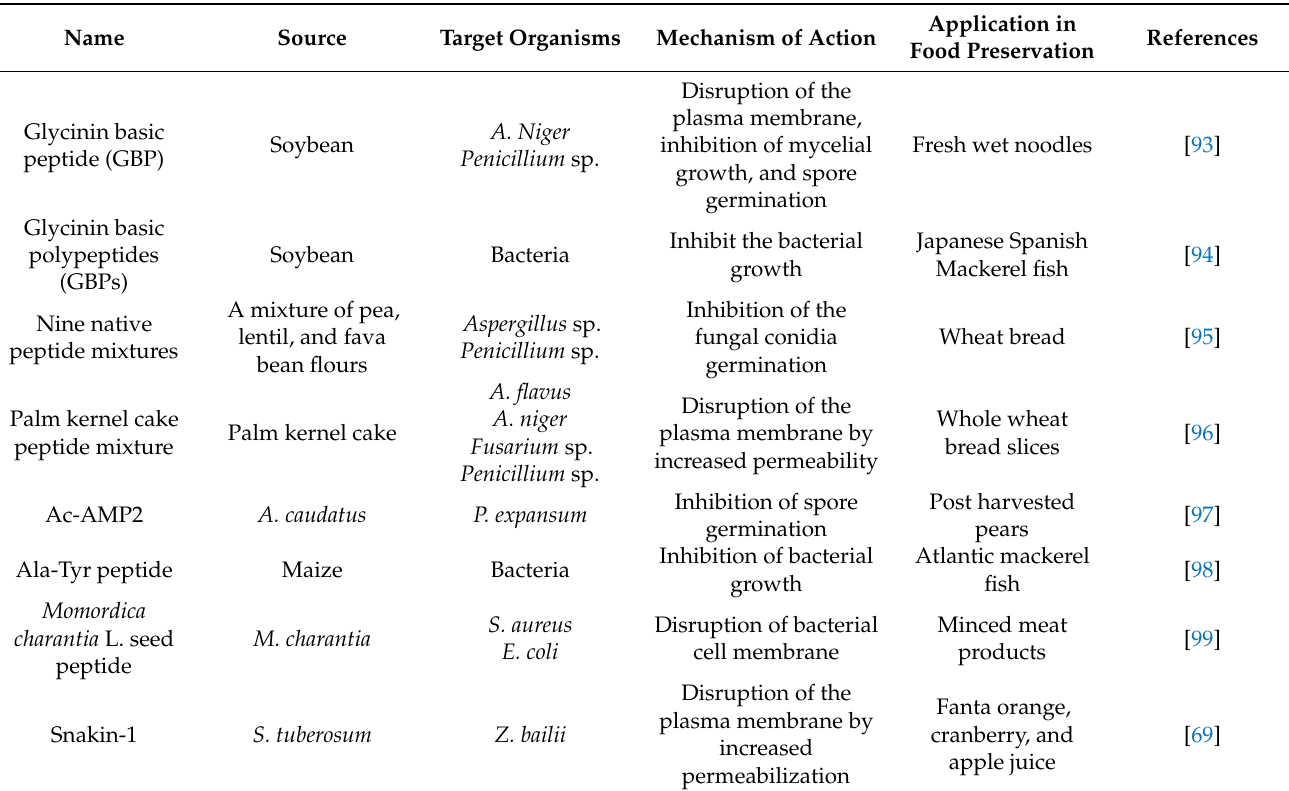
Table 2. Application of plant AMPs as food preservatives in the food